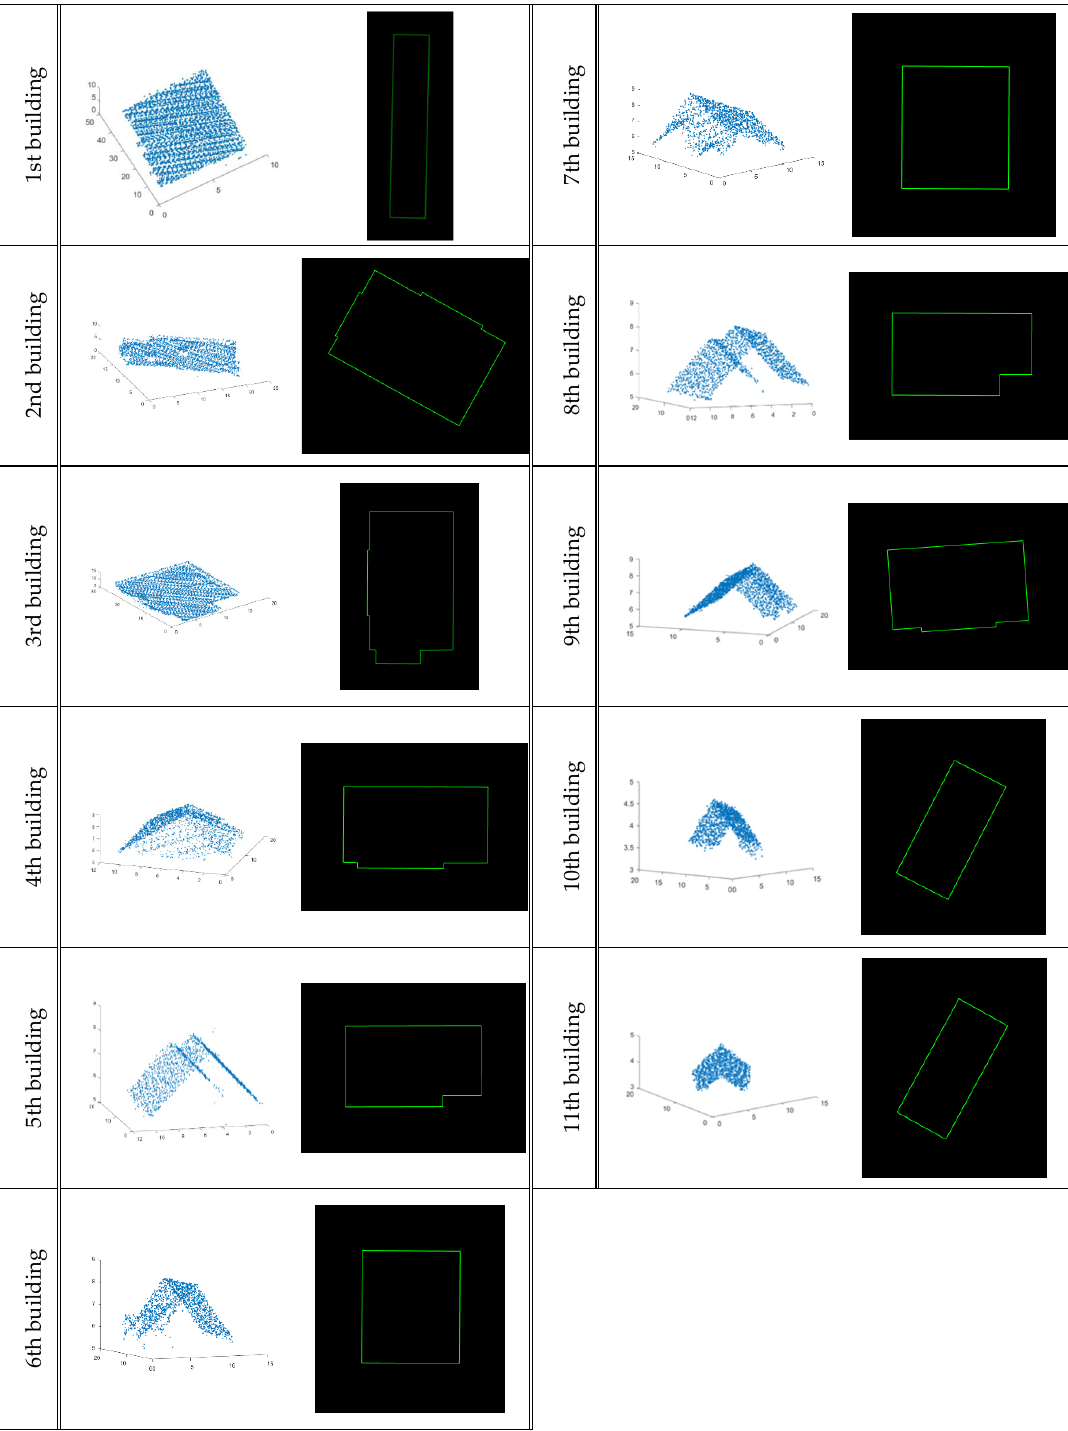
Figure 12. Point clouds and the border of changed buildings.